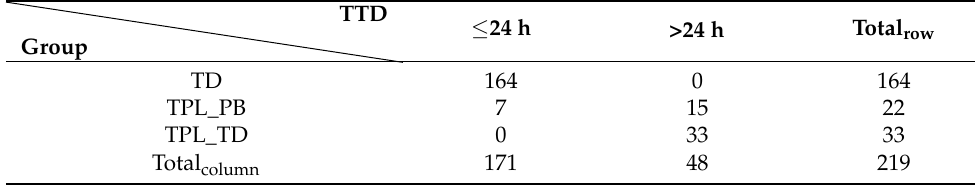
Table 1. Number of pregnant women in different